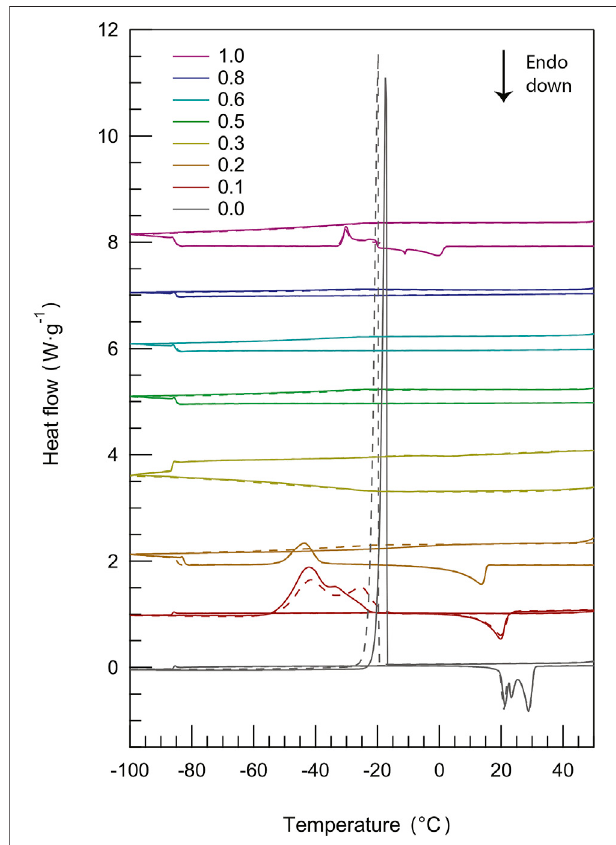
FIGURE2| Differential scanning calorimetry (DSC) curves recorded during cooling and heating scans (two cycles) for all protic ionic liquid mixtures, with the content of [C 2 HIm][TFSI] increasing from bottom ( χ = 0.0) to top ( χ = 1.0).